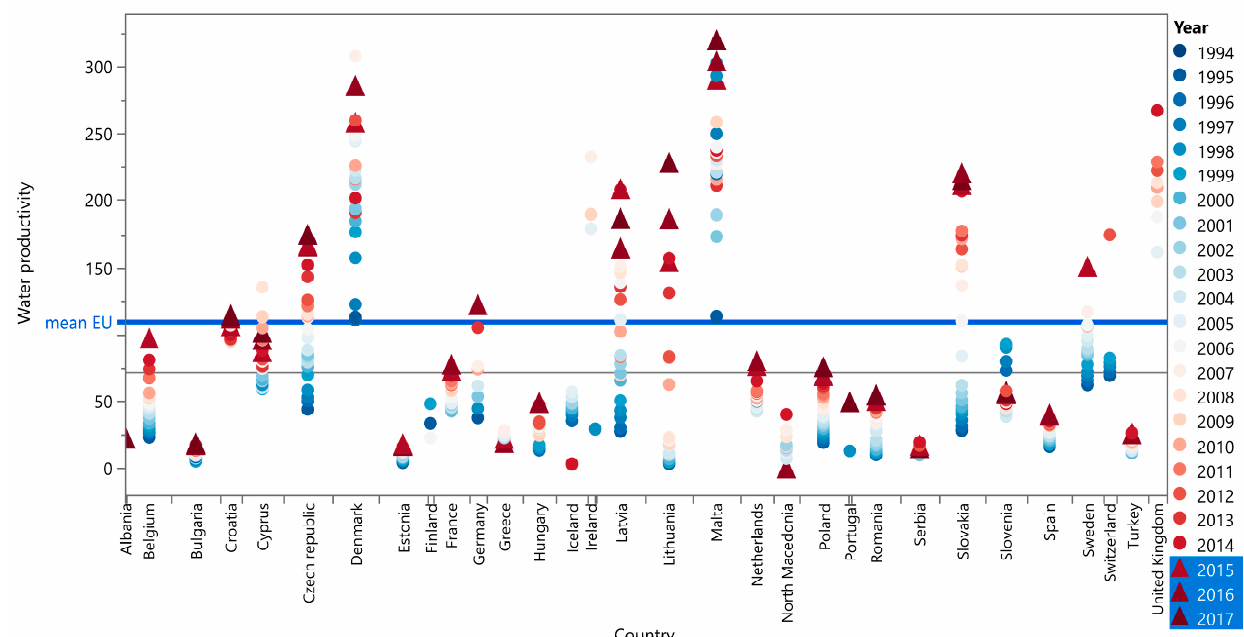
Figure 8. Analysis of variability according EU member states: water productivity (PPS/m 3 ).